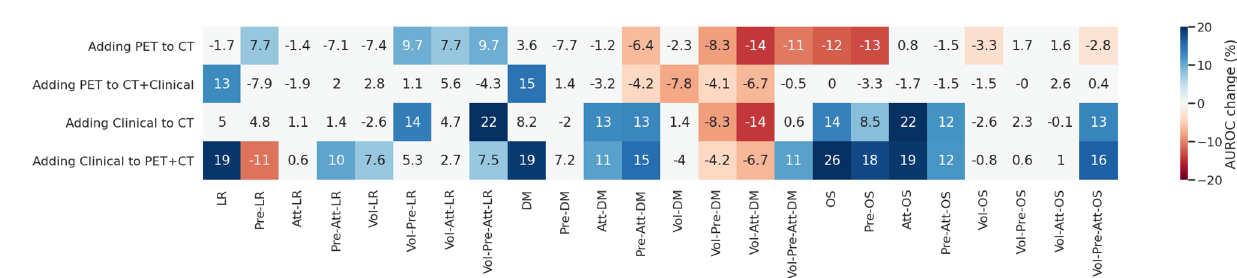
Figure 3. Effect of adding clinical data or PET images combined to the baseline CT. Columns represent different architectures used in the ablation experiments, for each of the predicted targets. Figures are percentage change in mean AUROC with the addition of the indicated modality to the indicated base modalities. Figures and colors represent the effect size for cases where a statistical significance was found ( p value < 0.05). Squares in white indicate no statistically significant difference was found. Figure created with seaborn/matplotlib v0.11.2